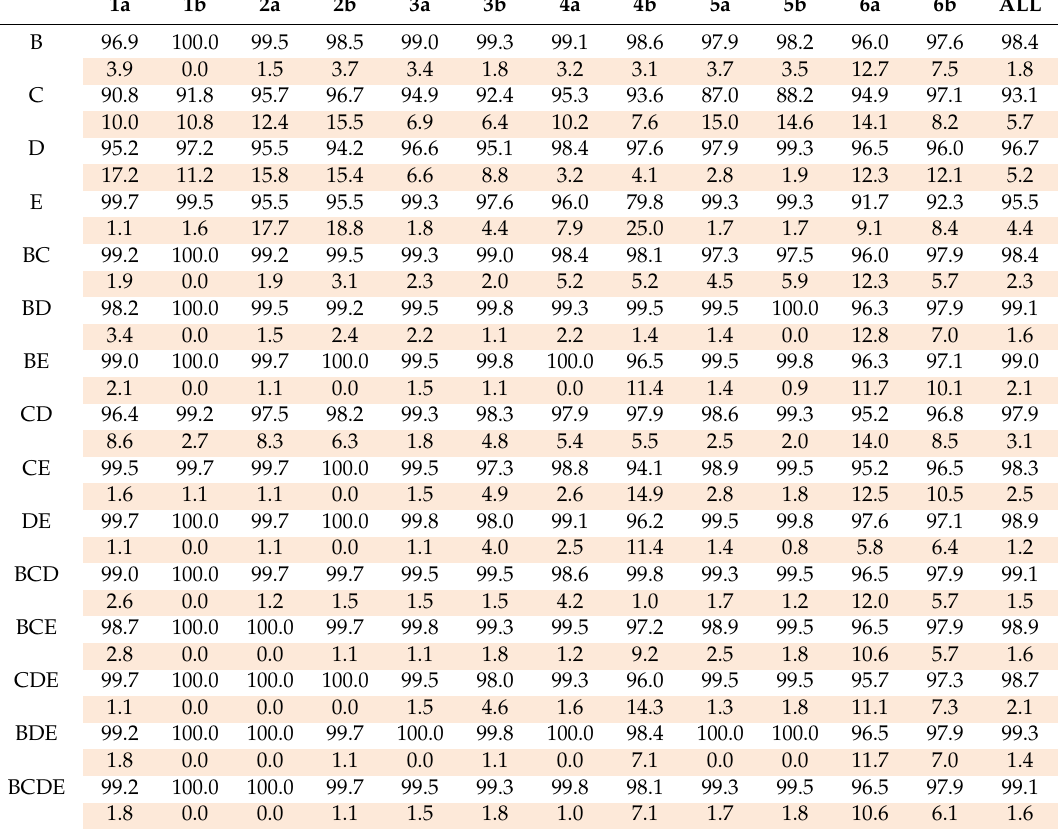
Table 3. Table of recognition R s_a (in %) of motion activities 1a ÷ 6b in the test set for all volunteers together for sensors B ÷ E and their sets. Calculation errors U s_a are placed in orange